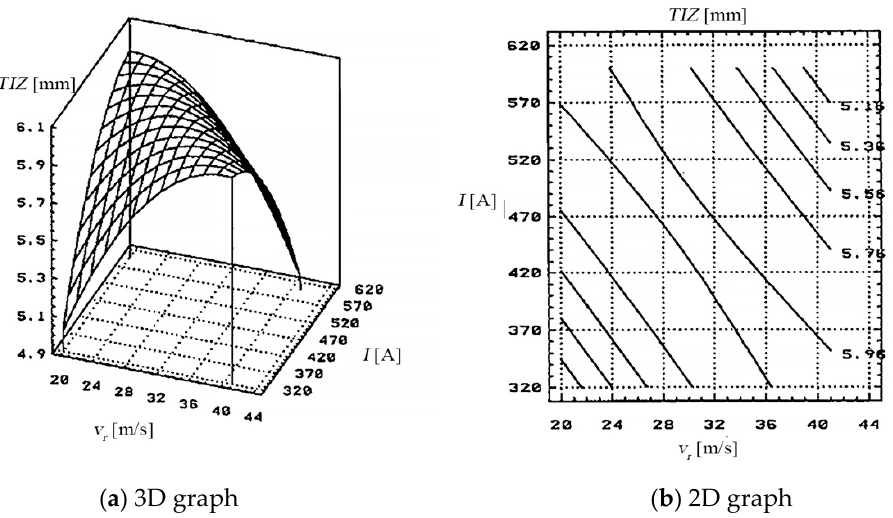
Figure 20. The dependency of the thermal influenced zone ( TIZ ) to the relative speed ( v r ) of the transfer object and the working current ( I ): ( a ) 3D graph, ( b ) 2D graph.